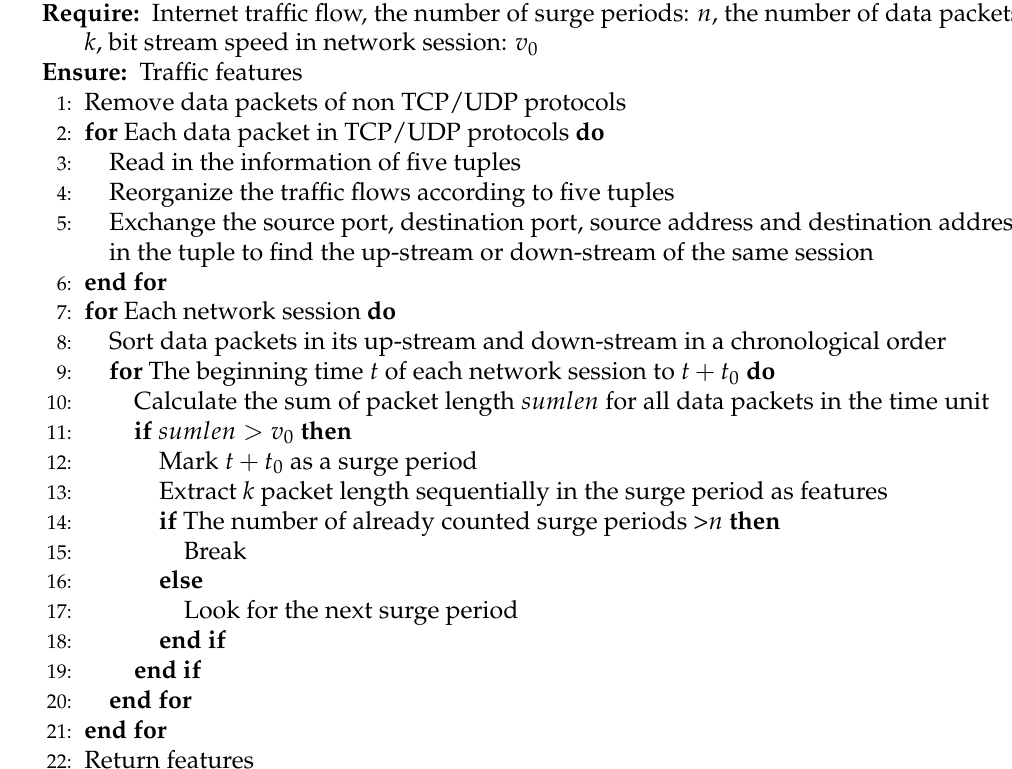
Algorithm 1 The surge period-based feature extraction method of unknown Internet traffic